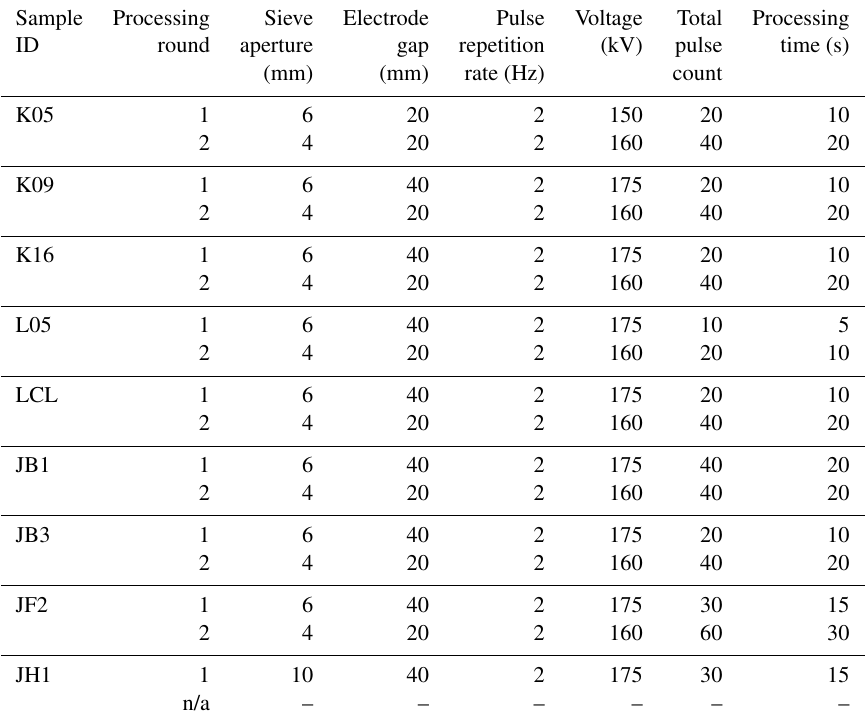
Table 3. First- and second-round process conditions for EPF-treated samples. Sieve aperture was selected based on measurement of visible LF. The electrode gap is smaller for K05 due to much smaller sample mass. Sample JH1 was not reprocessed as all material was processed successfully in the first processing